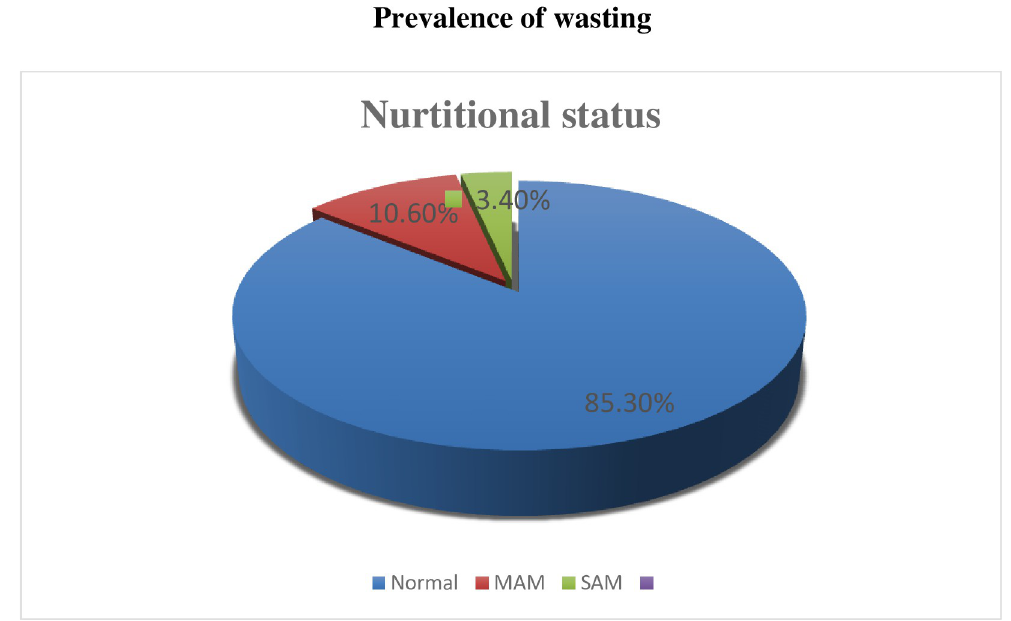
Fig 1. Prevalence of wasting among children from 6–59 months, in Wolkite Town, Southern Ethiopia, 2020/2021.